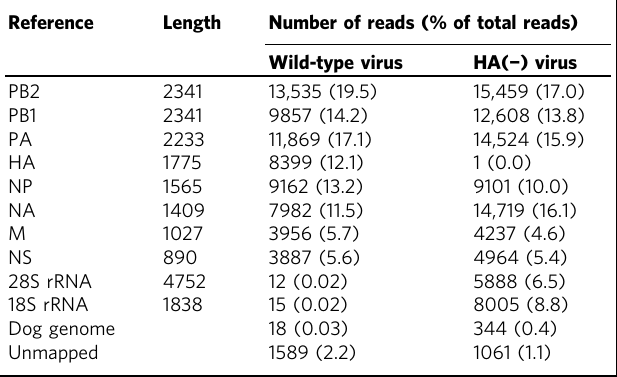
Table 1 Packaged RNAs in wild-type and HA( − ) virions Reference Length Number of reads (% of total